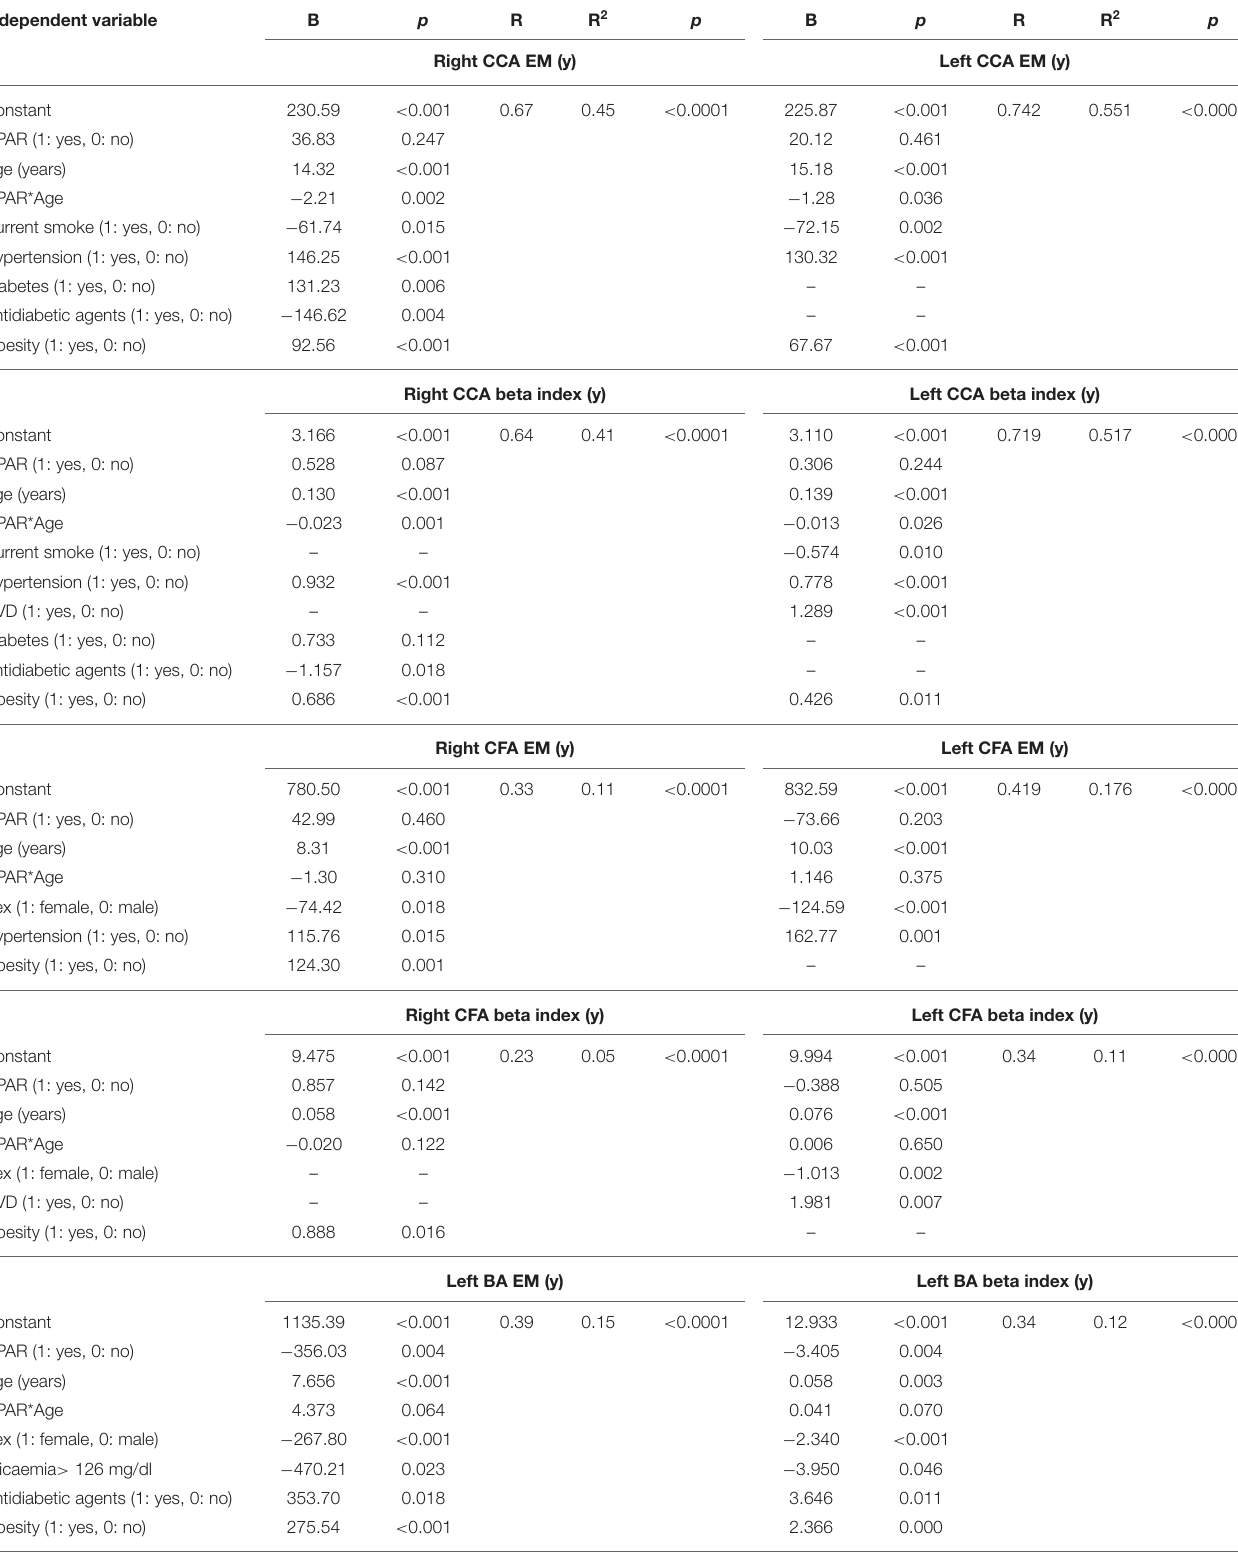
TABLE 7 | Association between CPARs and local arterial stiffness, with age as a moderating variable. Independent